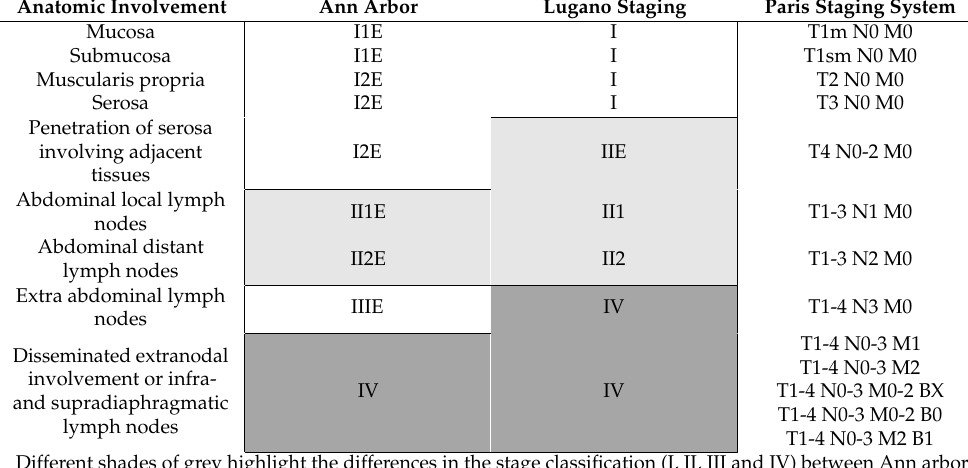
Table 1. Different staging systems for gastric EMZL. Anatomic Involvement Ann Arbor Lugano Staging Paris Staging